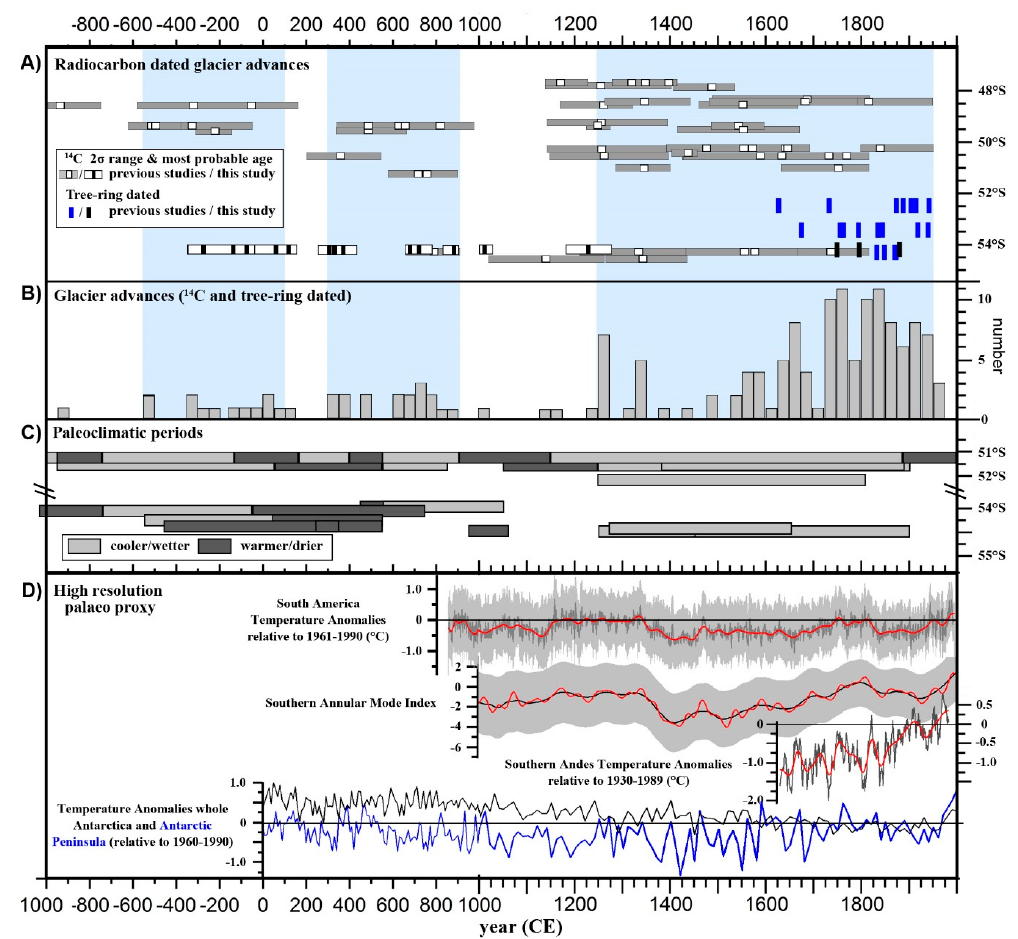
Figure 7. ( A ) Glacial advances depending on the latitude, displayed as calibrated 14 C 2- σ / 1- σ uncertainty range (for detailed list of the used references refer to Appendix B Table A2) and tree-ring-based moraine dates from the Tierra del Fuego region [16,117]. Blue vertical bars indicate phases of enhanced glacial activity. ( B ) Frequency of glacial advances at 25 year intervals, including tree-ring-derived advances compiled in Masiokas et al. [11]. ( C ) Paleoclimate studies representing (un)favorable climatic conditions for glacial expansion (Table A2). ( D ) High resolution palaeoclimatic reconstruction for South America [118], Southern Annular Mode Index [119], Southern Andes Temperature Anomalies [120] (red lines represent the respective 11 year fast Fourier transform (FFT) filter for each time series), and Temperature Anomalies for the Antarctica [121].